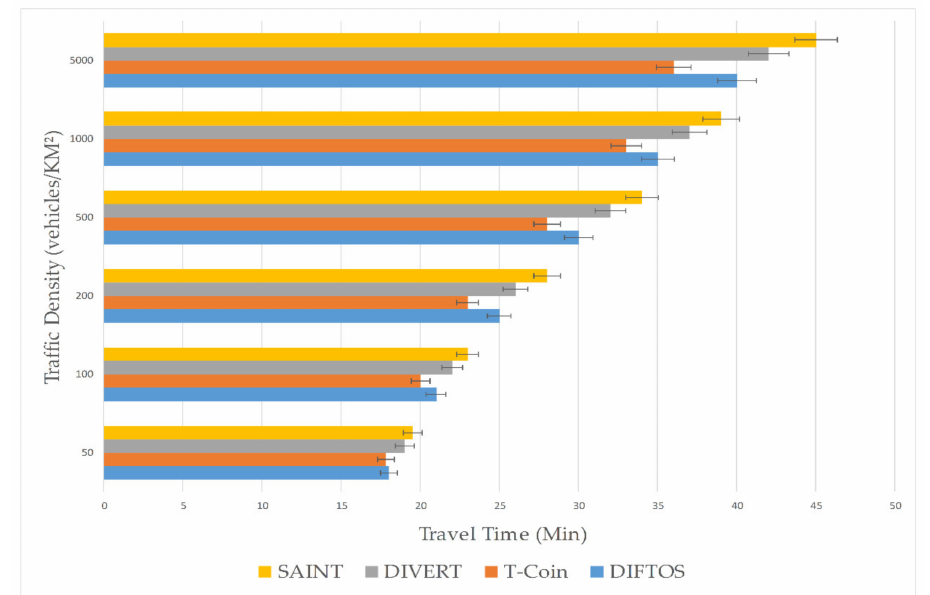
Figure 10. Tra ffi c density vs. average travel